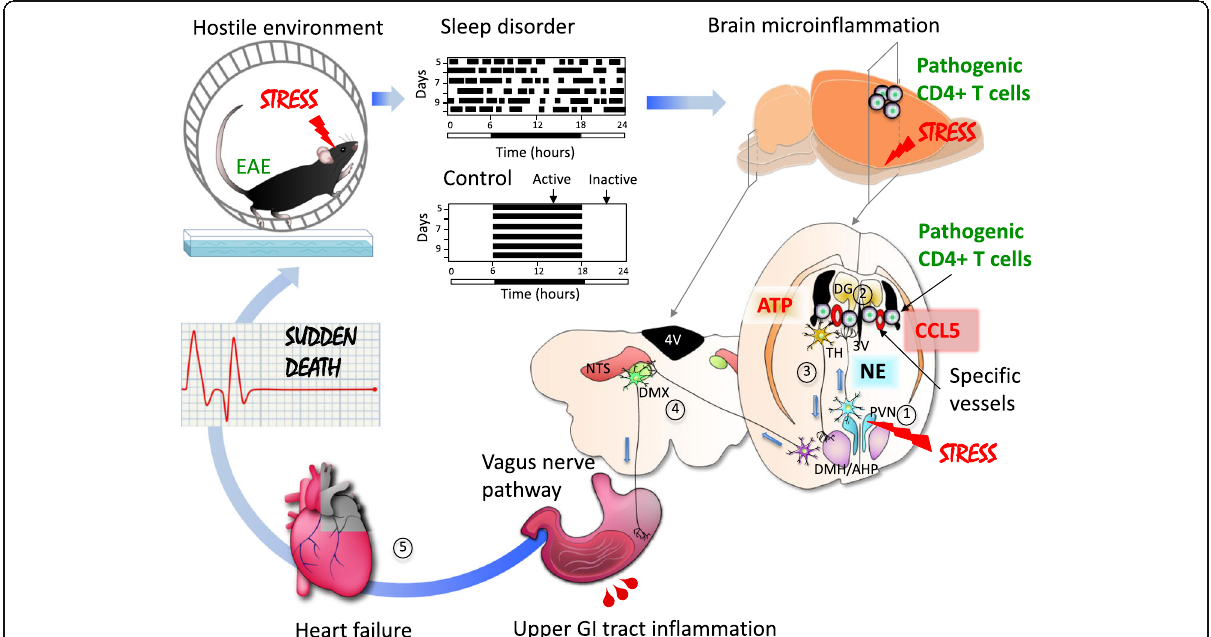
Fig. 4 Stress gateway reflex. Hostile environment induced by a specific cage with water and a free rotation wheel causes chronic stress associated with sleep disorder. In a mouse with adoptive-transfer EAE, this chronic stress stimulates noradrenergic neurons in the PVN (1), which then project to bilateral specific vessels surrounded by the third ventricle (3V), dentate gyrus (DG) and thalamus (TH) (2) to upregulate chemokines including CCL5 and recruit pathogenic CD4+ T cells plus MHC class II+ monocytes. The resulted microinflammation activates a neural pathway involving the DMH/AHP and DMX via ATP production (3). Hyperactivation of the vagus pathway particularly distributed the upper gastrointestinal (GI) tract causes a severe damage in the upper GI tract followed by a heart failure with sudden death (5). Abbreviations: AHP, anterior hypothalamic area; EAE, experimental autoimmune encephalomyelitis; PVN, paraventricular nucleus of the hypothalamus; DMH, dorsomedial nucleus of the hypothalamus; DMX, dorsal motor nucleus of the vagus nerve; NTS, nucleus tractus solitarii; 4V, fourth